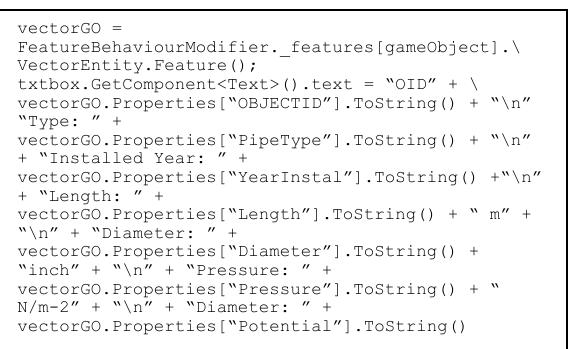
Figure 11. Fragmented script for retrieving attributes of each